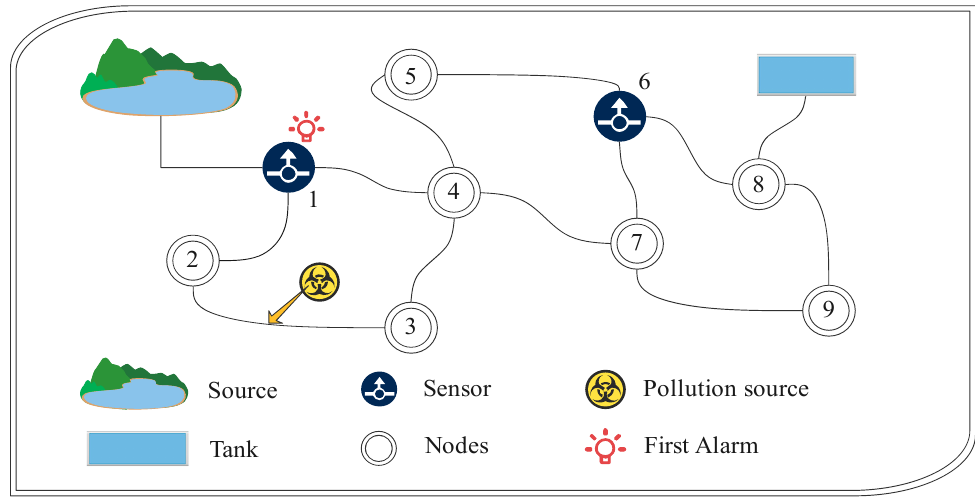
Figure 1. Layout of the water quality sensors in a small WSN (9 nodes, 2 sources, 1 tank, 13